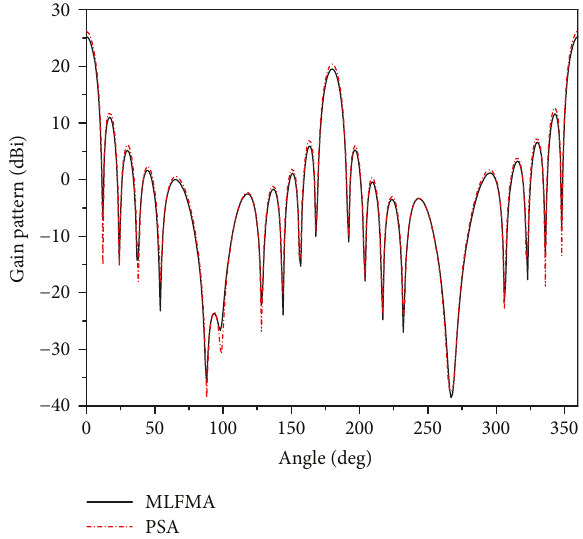
Figure 5: Radiation patterns of the 10 × 10 antenna array with